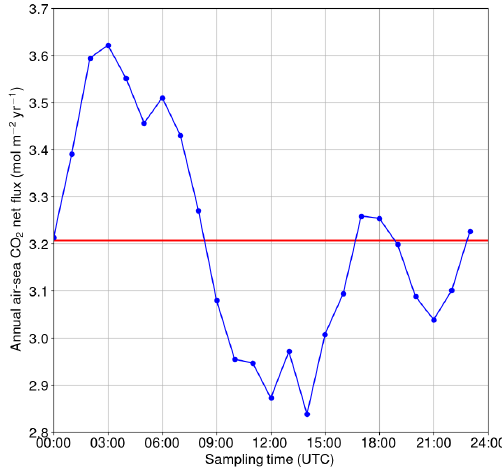
Figure 10. Annual net flux of carbon dioxide between the sea and atmosphere if only one measurement per day is used. The reference (the red line) is based on high-frequency